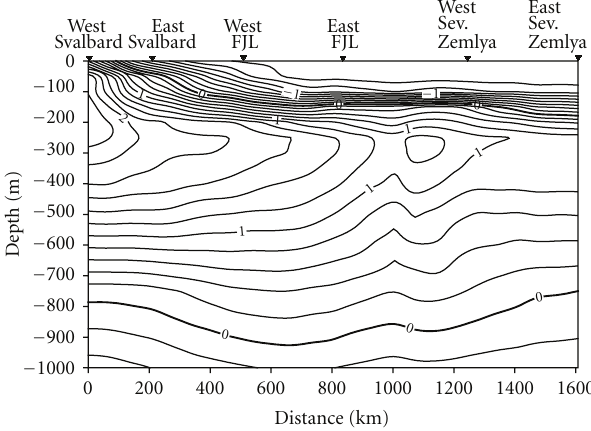
Figure 2: Temperature, ◦ C section along the FSBW inflow in summer season (EWG, 1998) (FJL: Franz Joseph Land).